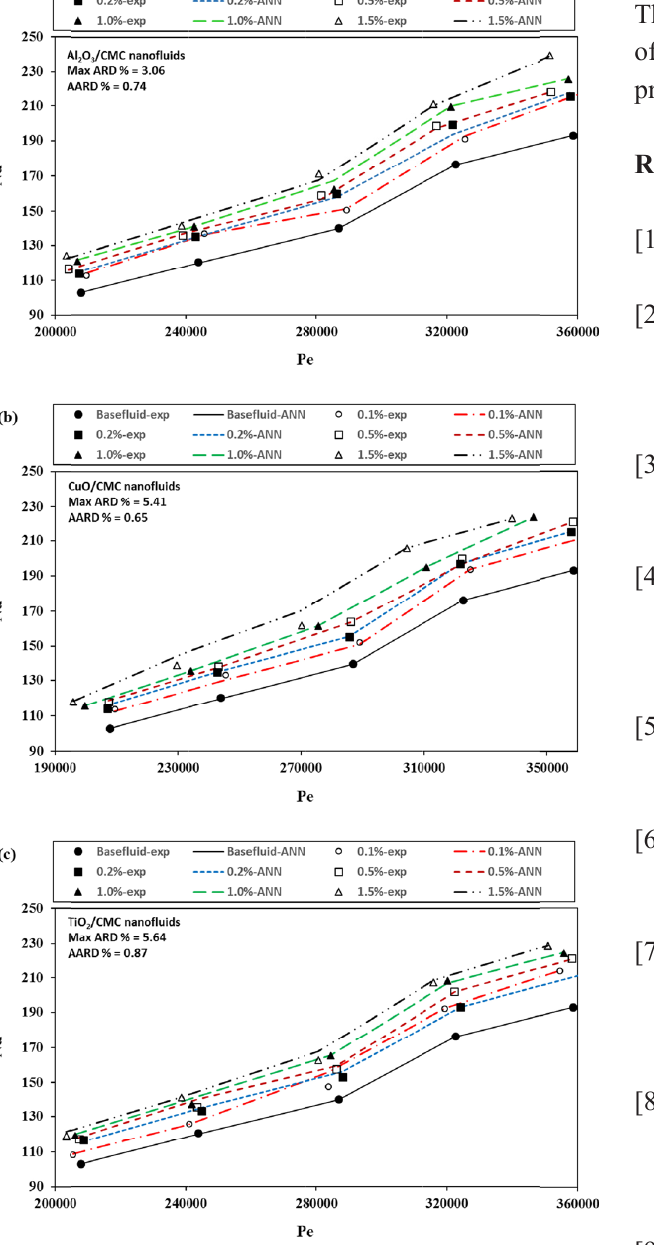
Fig. 5. Comparison between experimental data [16] and values predicted by the ANN (a)Al 2 O 3 /CMC, (b) CuO/CMC and (c)TiO 2 / CMC